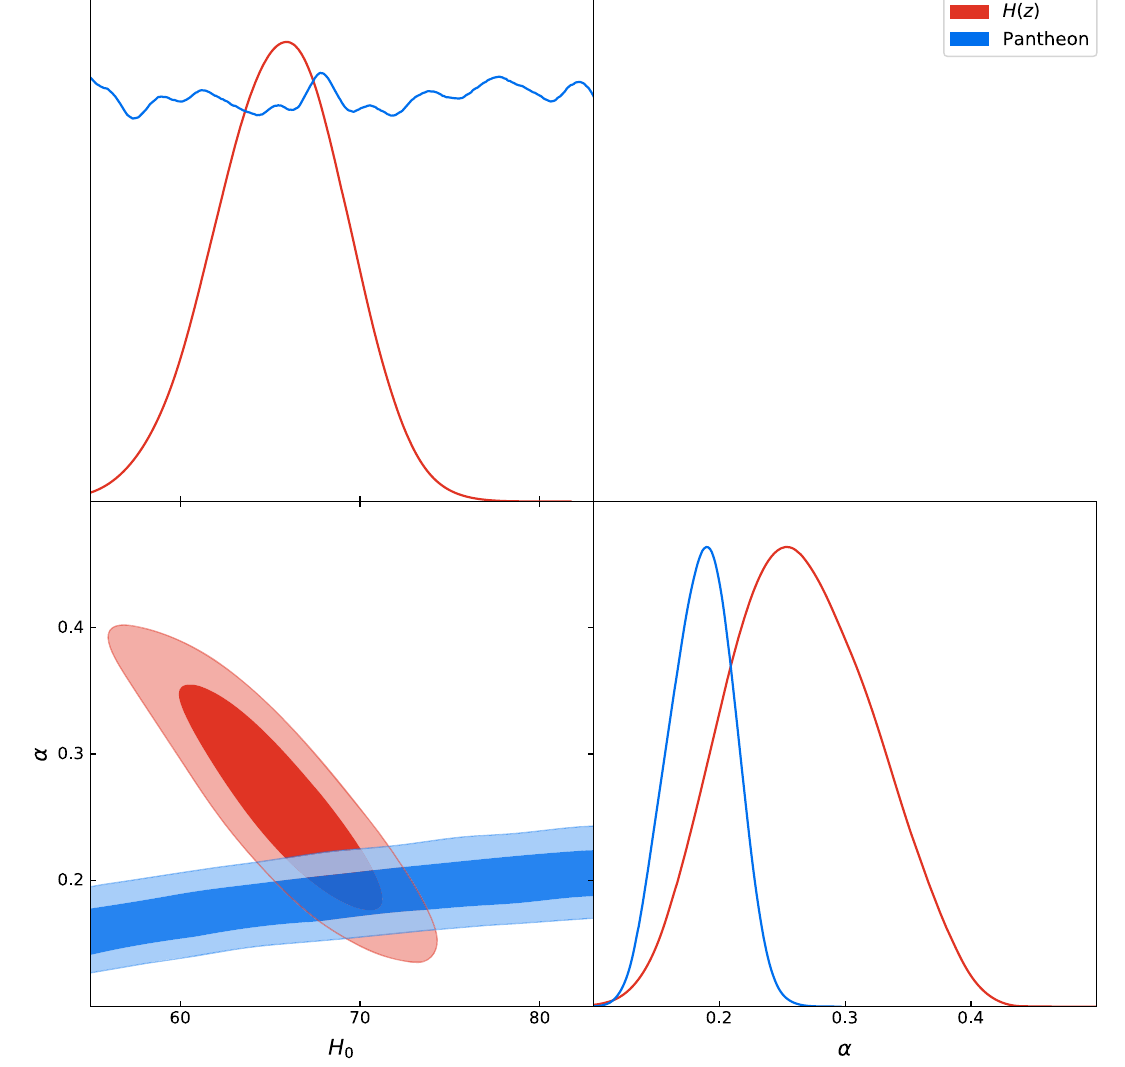
Fig. 3 Separate analysis using SNe Ia – Pantheon (blue) and 31 H ( z ) data – Cosmic Chronometers (red), for the constraints of the main parameters, H 0 and α , for Case